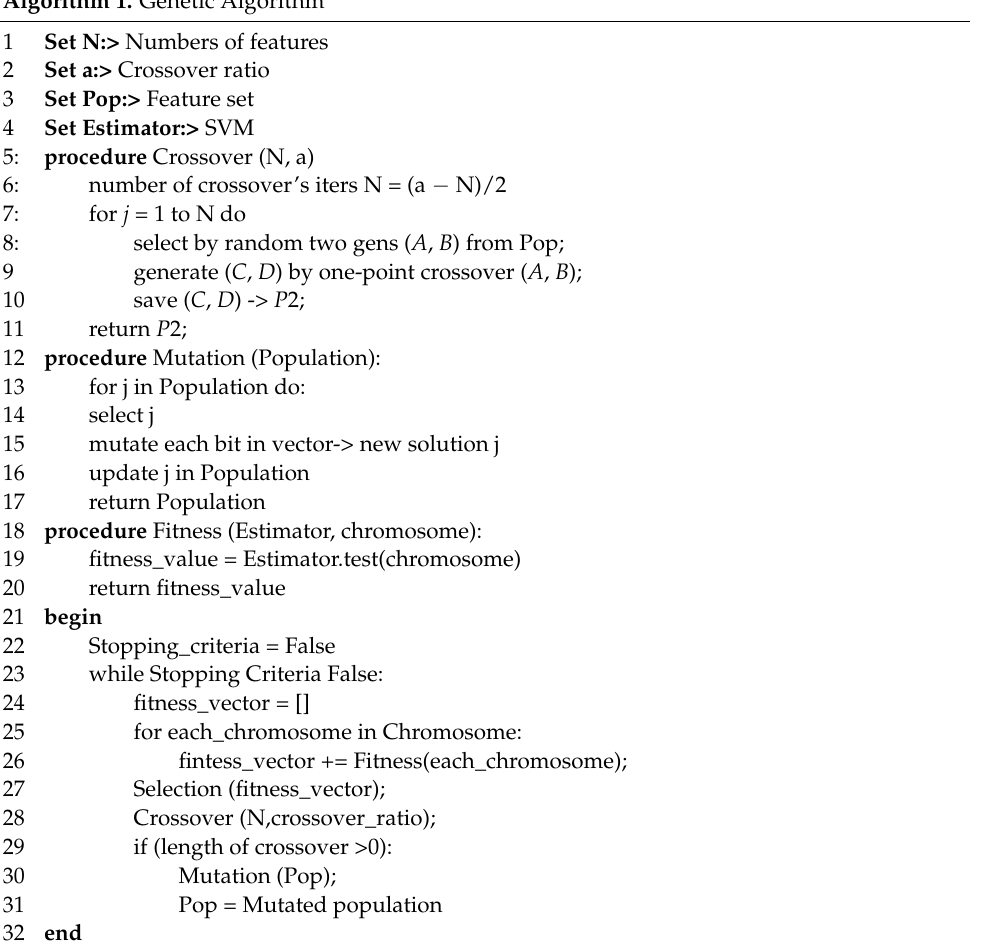
Algorithm 1. Genetic